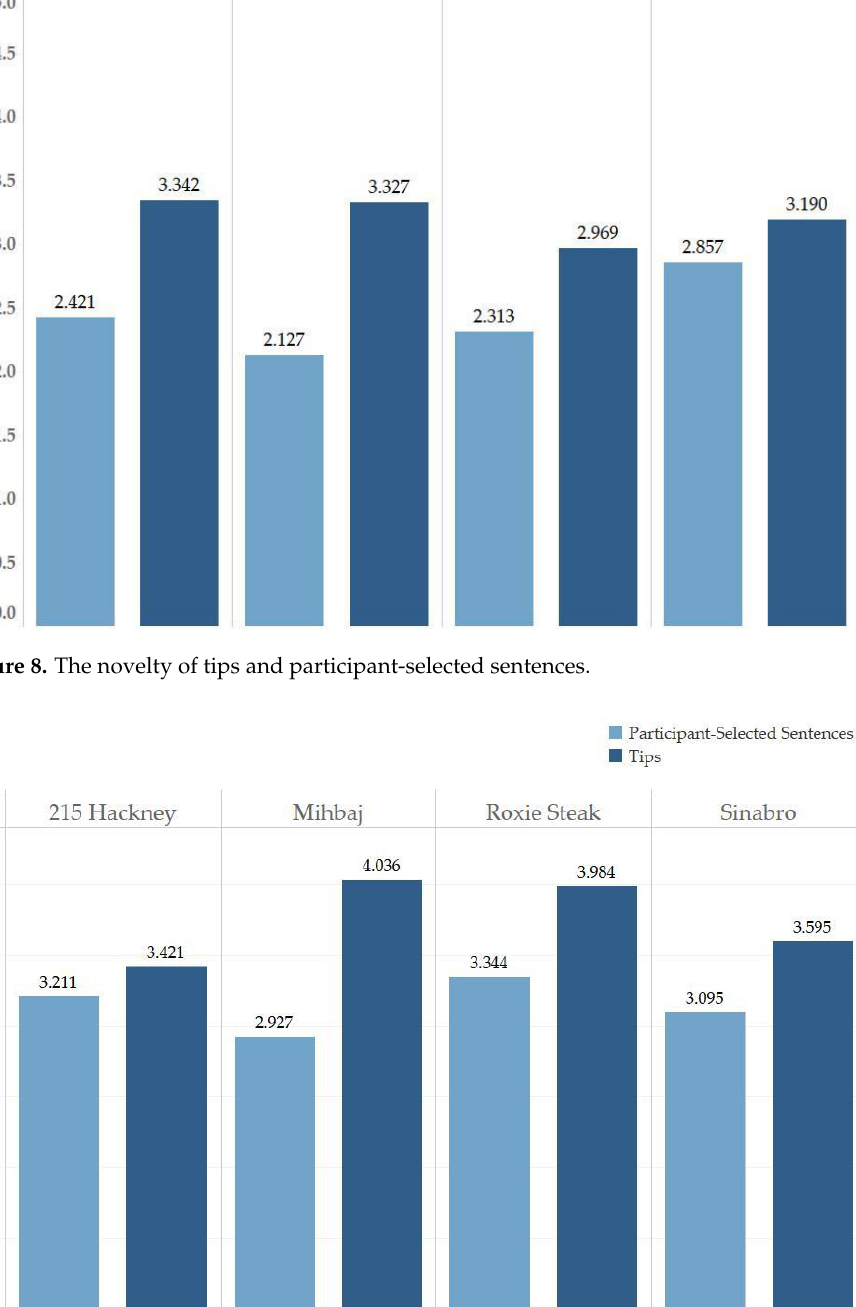
Table 5. Result of Study A1.